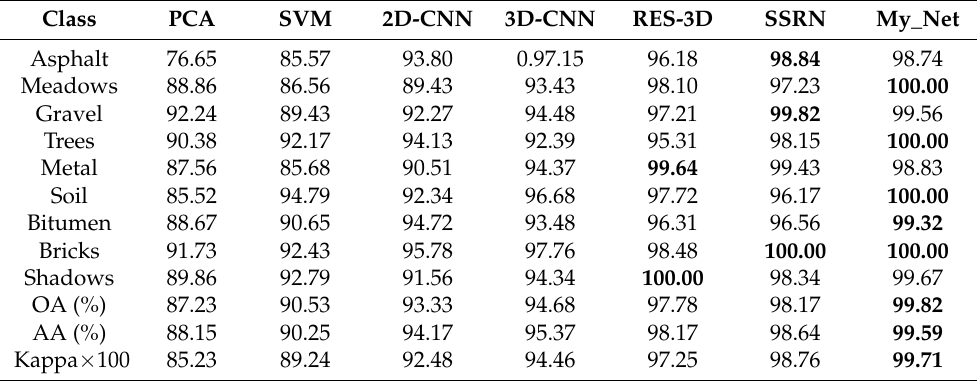
Table 4. Classification results of different models in Pavia University.